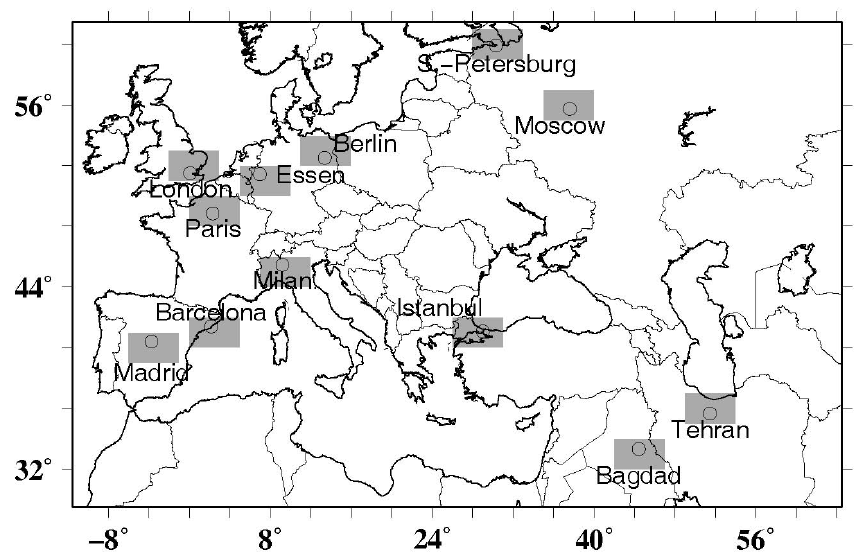
Fig. 1. The areas attributed in model simulations to the megacity regions considered in this study. obtain full global coverage (6 days). The ENVISAT-1 over- pass time is 10:00 LST at the